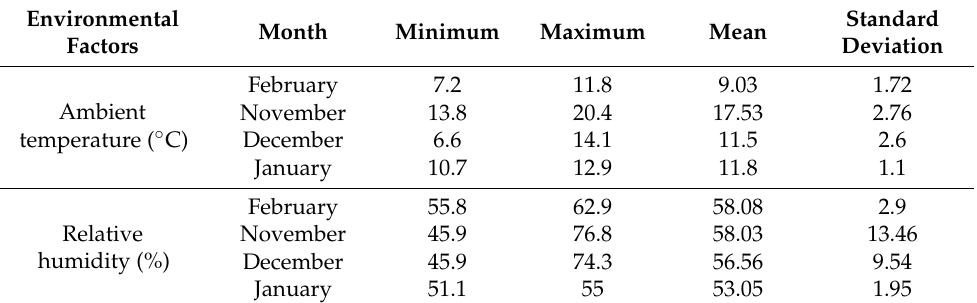
Table 1. Ambient temperature ( ◦ C) and humidity (%) conditions according to season during infrared thermography